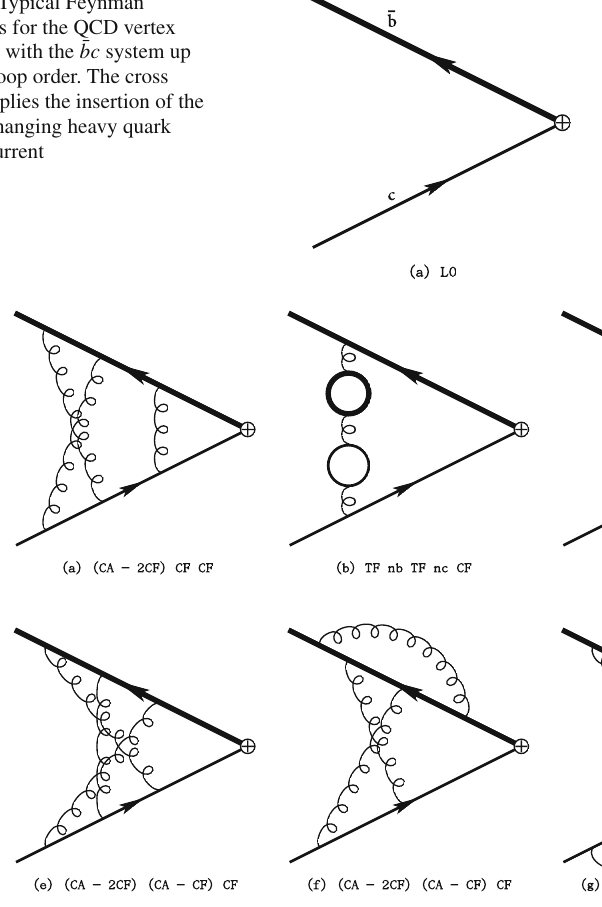
diagrams for the QCD vertex function with the ¯ bc system up to two-loop order. The cross (cid:21) “ ” implies the insertion of the